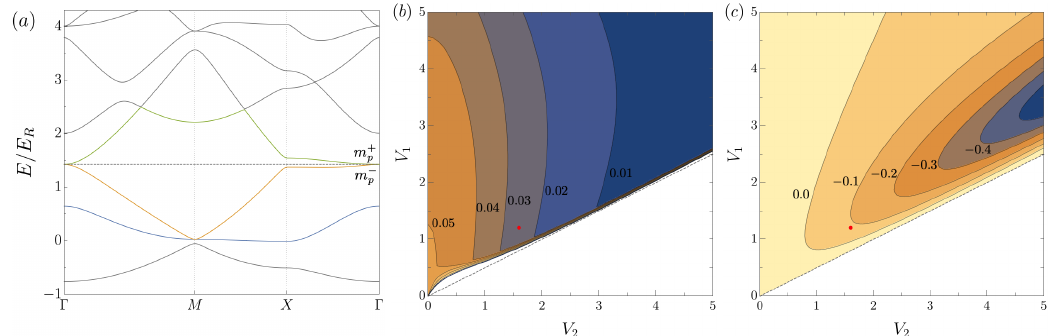
Figure 9: (a) The band structure obtained from the optical lattice potential [ Eq. (A.1) ] , and plane wave basis of the Bloch wavefunction [ 36 ] for V = 1.2 E V . The three band tight-binding model in the main text corresponds to R 2 the three colored band. The chemical potential required for to reach the QBT at 3 atoms per site is depicted as a dashed line. The contour plot shows the value of the ) − 1 and (c) ( 2 m − ) − 1 along the Γ − X line as a func- inverse effective mass (b) ( 2 m + p p tion of V , V (corresponding bands are indicated in (a)). We indicate the proposed 1 2 = 1.6 E = 1.2 E parameters V , V as a red dot, and the dashed line is the V R R 1 2